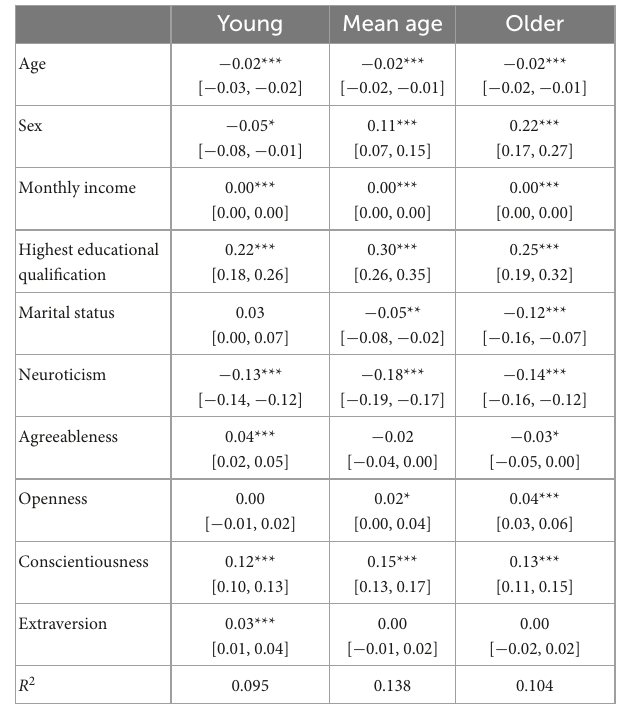
TABLE 6 The regression coefficient ( b ) for demographics and personality traits with the total explained variances ( R 2 ) for young ( < 40), middle-aged ( > 39 and < 60), and older people ( >